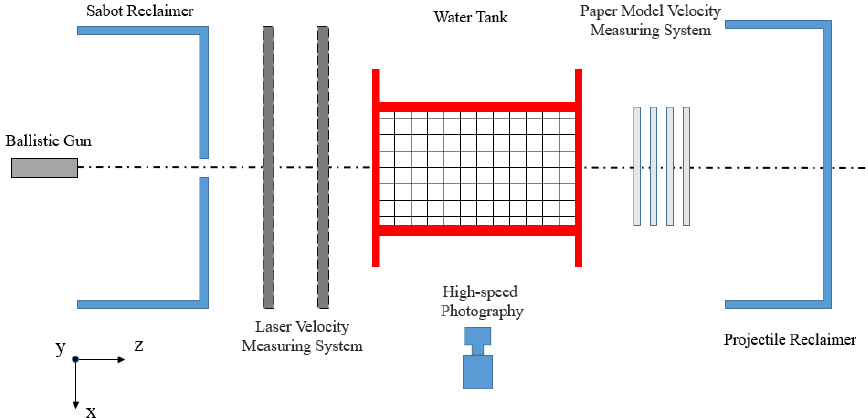
Figure 3. Experiment setup.